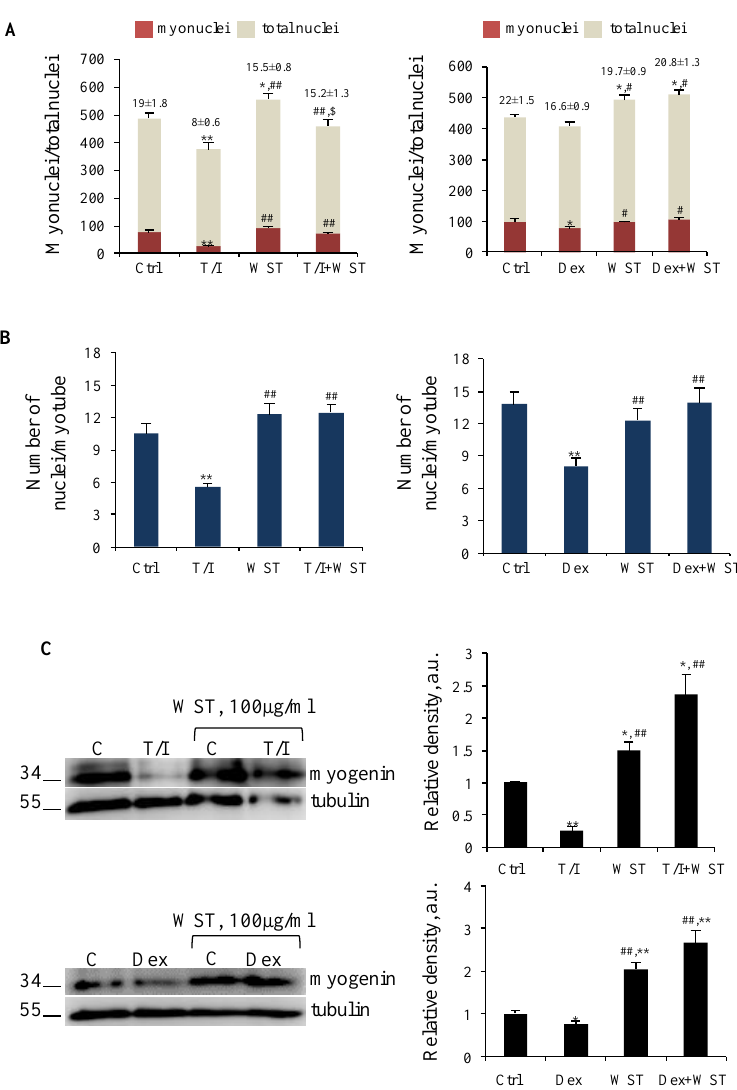
Figure 5. ( A – C ) C2C12 myotubes were treated with TNFα (tumor necrosis factor α, 20 ng/mL)/IFNγ (interferon γ, 100 U/mL) (T/I) or dexamethasone (Dex, 1 µM) in the absence or presence of WST for 48 h. The number of nuclei inside myotubes and the total nuclei were counted and the fusion index was calculated and reported ( A ). The average nuclei inside each myotube was calculated ( B ). WB (western blotting) analysis for Myogenin were performed ( C ). Tubulin was used as a loading control (C). Reported are representative images and the relative densities with respect to tubulin ( C ). Results are means ± SD (standard deviation) ( A – C ). Statistical analysis was conducted using t-test * p < 0.05, ** p < 0.01 significantly different from untreated control; # p < 0.05 and ## p < 0.01 significantly different from T/I or Dex; $ p < 0.05 significantly different from WST.